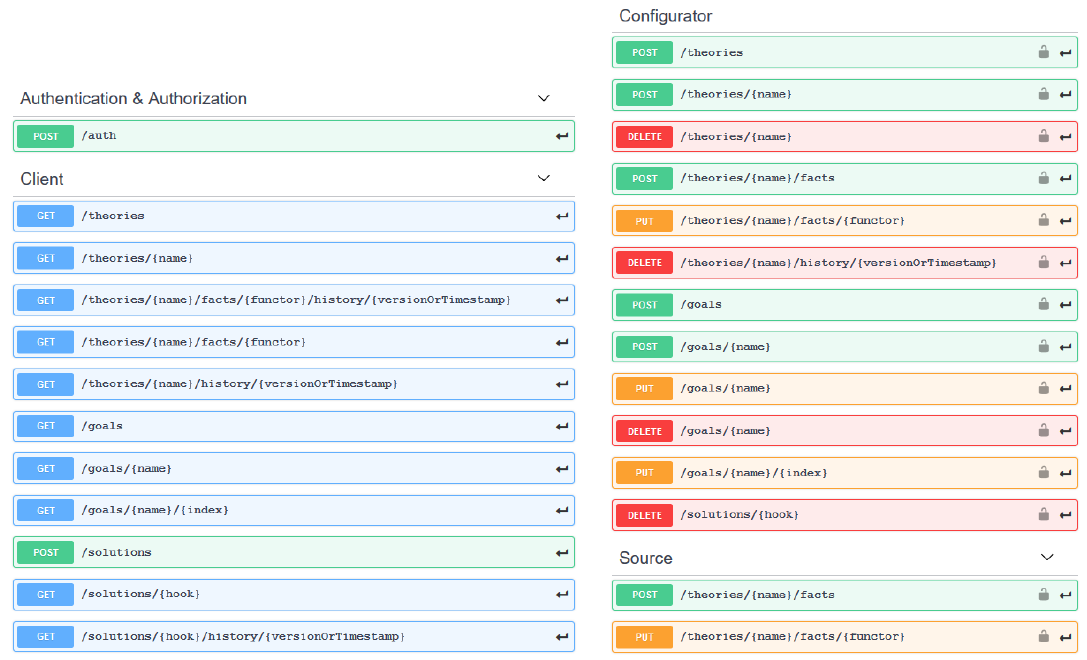
Figure 4. The LPaaS RESTful API. For further details please refer to the LPaaS Home Page